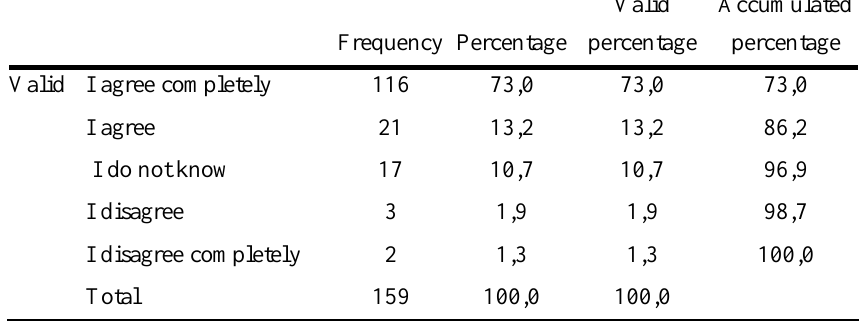
Valid percentage questionnaires´ results, question 1 “Students are pleased when using the foreign language among themselves”.